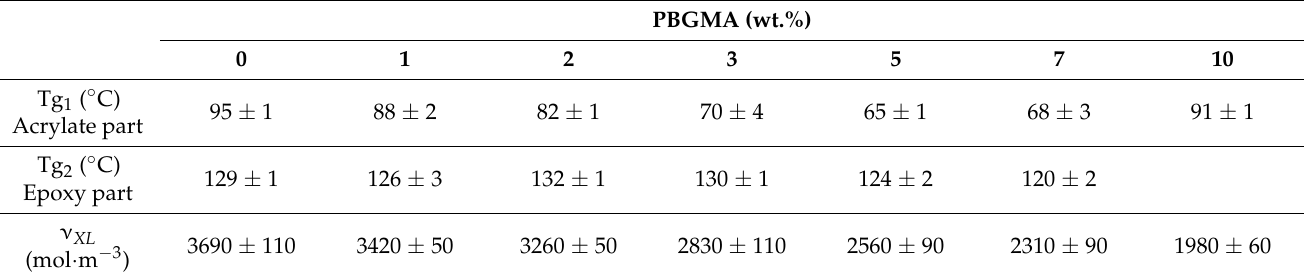
Table 4. T g (s) of the (meth)acrylate and epoxy domains, as well as overall crosslinking densities obtained via DMA. Data are presented for the reference ternary mixture (0 wt.% PBGMA) and samples with varying wt.% of PBGMA (all mixtures contained 1 wt.% radical photoinitiator and 3 wt.% cationic photoinitiator). The T g s of the (meth)acrylate (1:1 PBUDA:HDDMA) and the neat epoxy was 86 and 178 ◦ C, respectively.